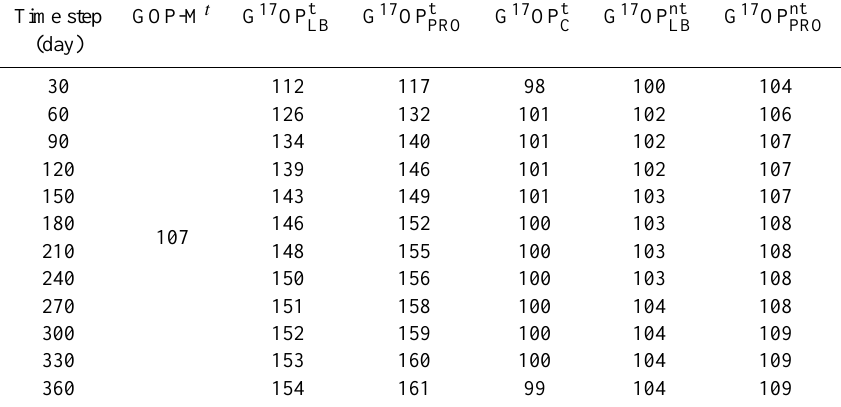
Table 1. Results of model simulation with a constant mixed-layer depth of 40m GOP-M – input GOP rate, G 17 OP LB – Luz and Barkan (2000), G 17 OP PRO – Prokopenko et al. (2011), G 17 OP C – this work includes a correction for turbulent flux of O 2 from the thermo- cline. All GOP rates are in mmolm − 2 day − 1 . In the columns marked with t, κ = 10 − 4 m 2 s − 1 , whereas in the columns marked with nt, κ = 10 − 6 m 2 s − 1 , which effectively shuts down the turbulent flux of O 2 between the thermocline and the mixed